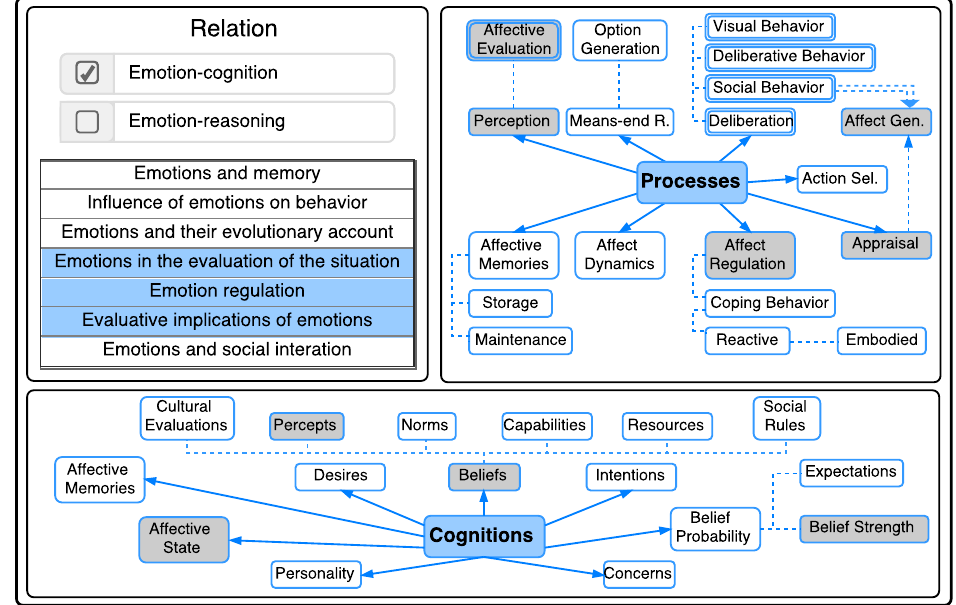
Figure 9. Processes and cognitions of the Affective Belief Revision